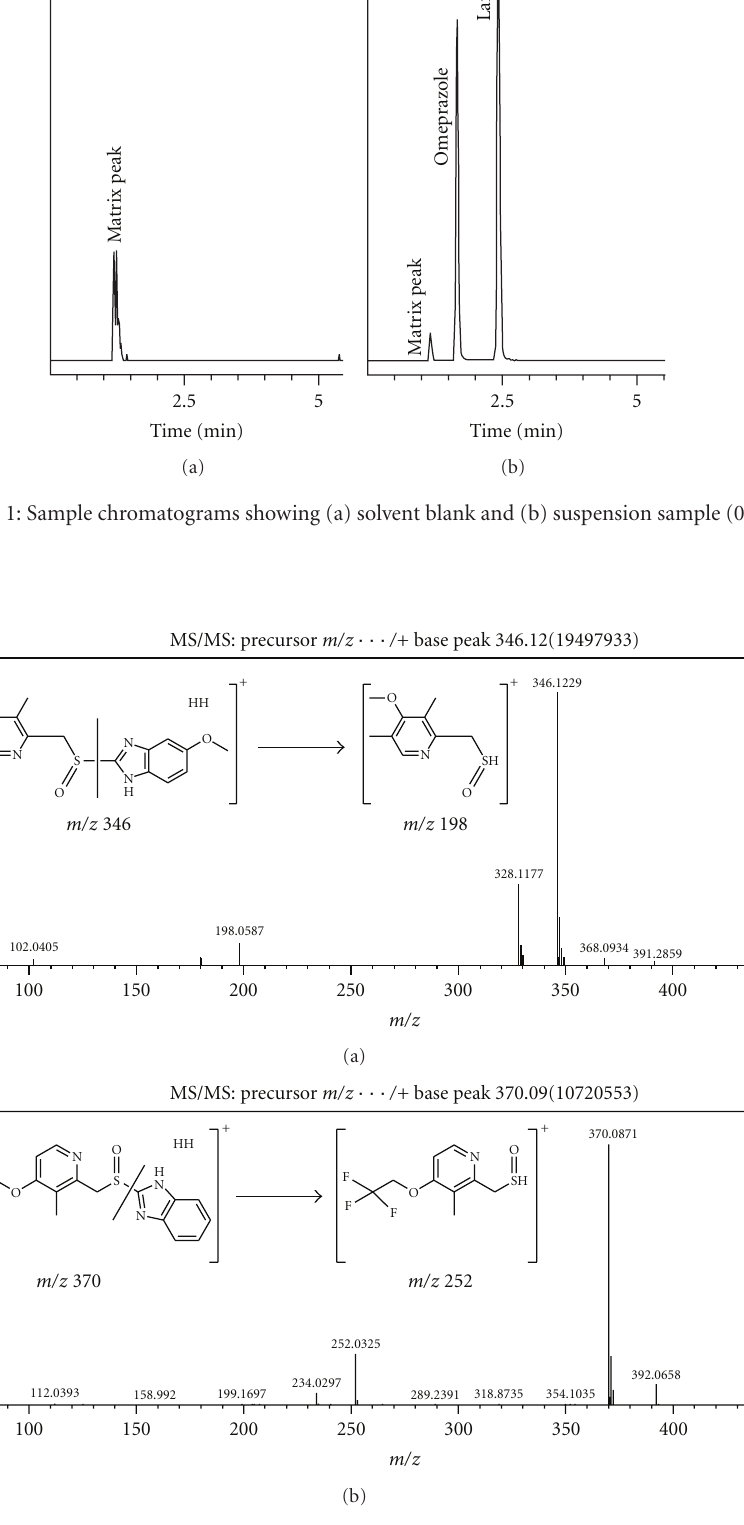
Figure 2: LC-MS/MS transitions monitored for the quantification of (a) omeprazole and (b)